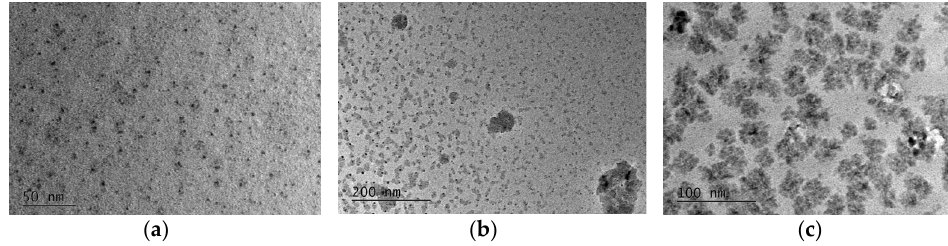
Figure 4. TEM images of NaPA@MAC hybrid with scale bar = 50 nm ( a ), 200 nm ( b ) and 100 nm ( c ).